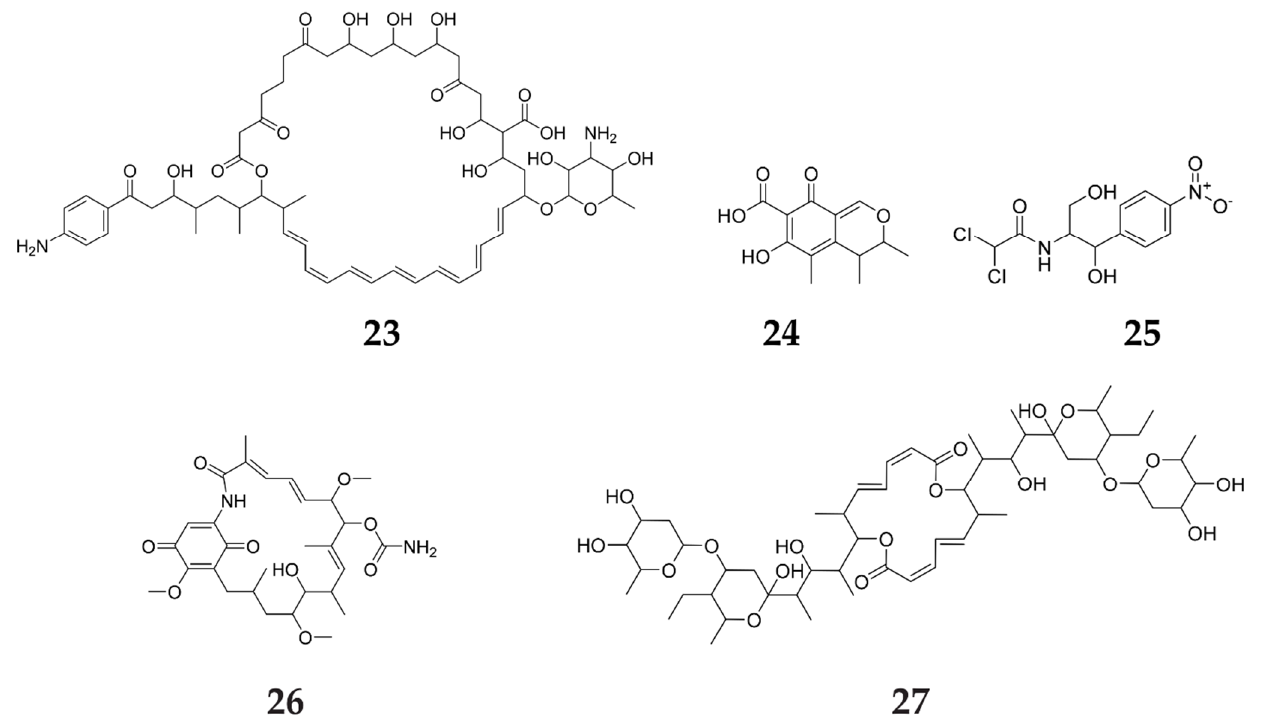
Figure 4. Secondary metabolites elicited by cross-regulation from other regulators.